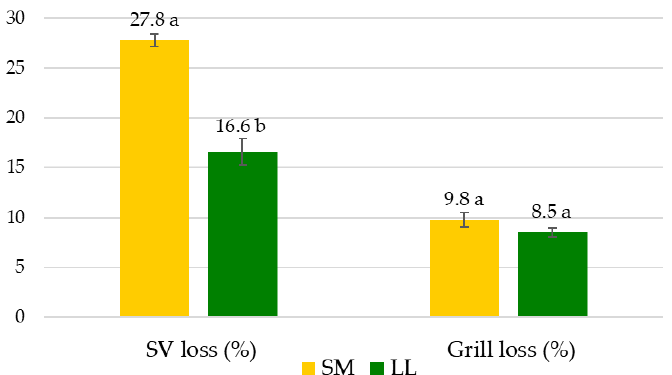
Figure 1. Sous vide (SV) and grilling (Grill) losses (%) in samples of semimembranosus and longissimus lumborum muscles subjected to sous vide and grilling (SVGrill) treatment. Vertical bars indicate standard error of the mean, and a and b represent values with different letters differing at p < 0.001.